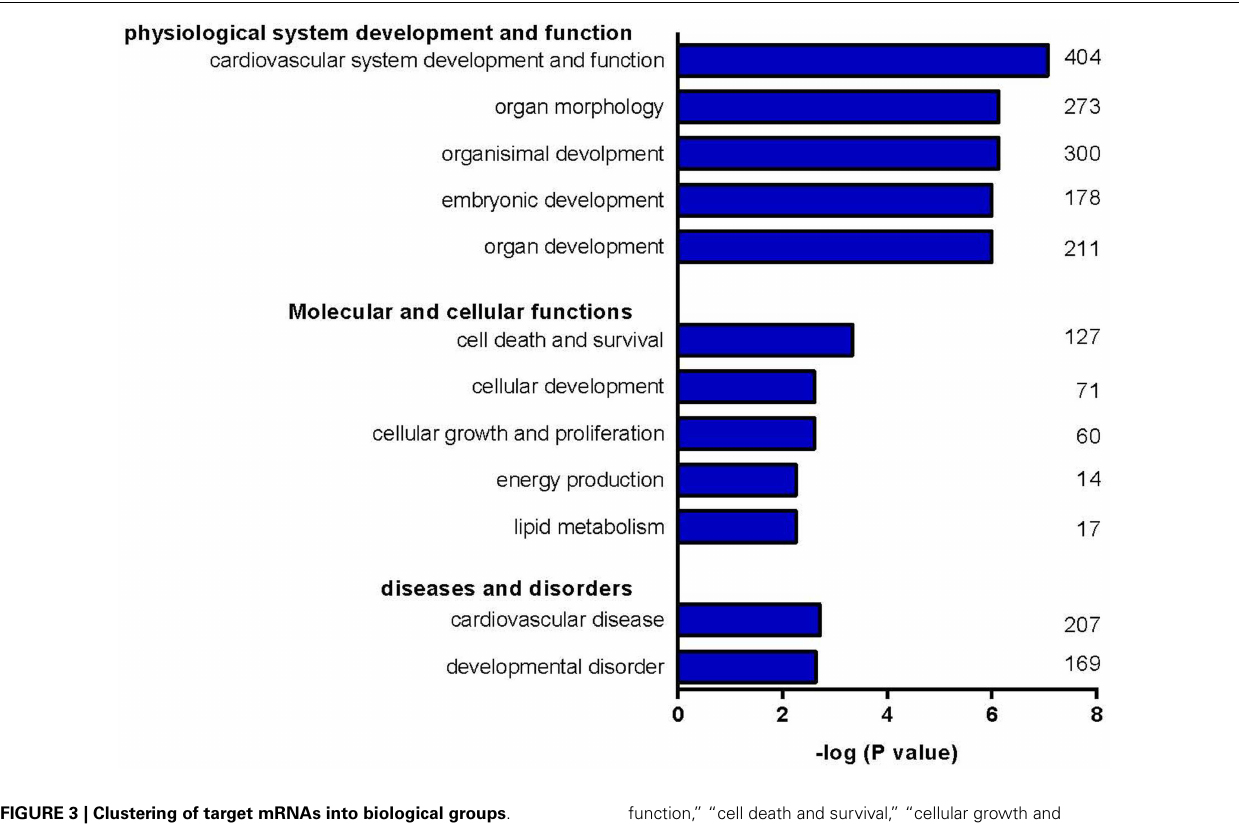
FIGURE 3 | Clustering of target mRNAs into biological groups . Clustering of predicted target mRNAs into biological groups was performed with IPA. Predicted target mRNAs were represented in processes involved in “cardiovascular system development and